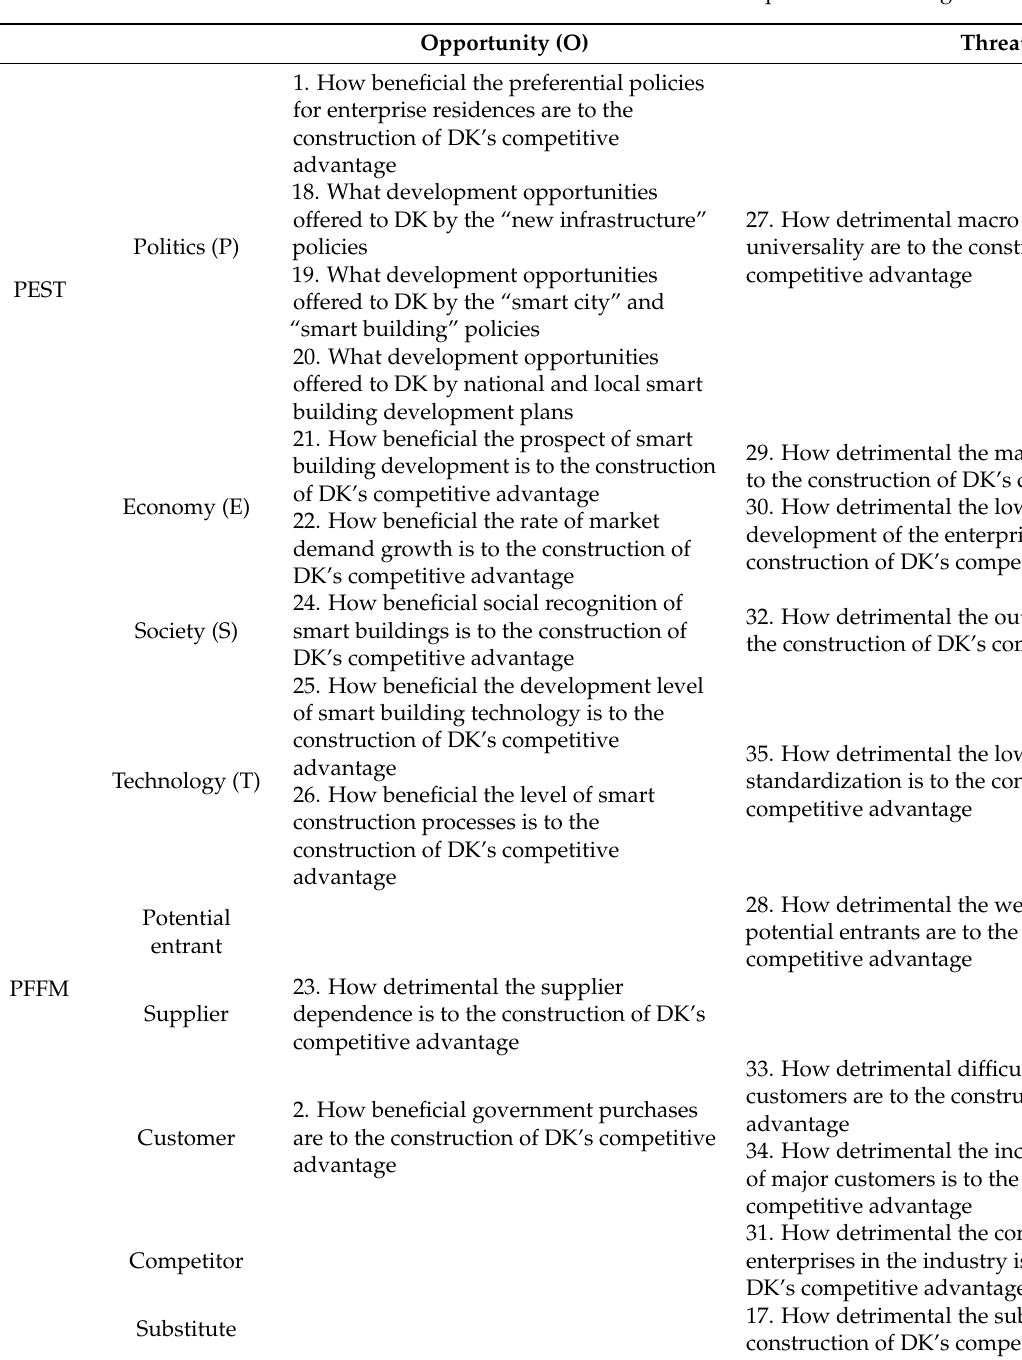
Table A2. External environment-oriented DK questionnaire